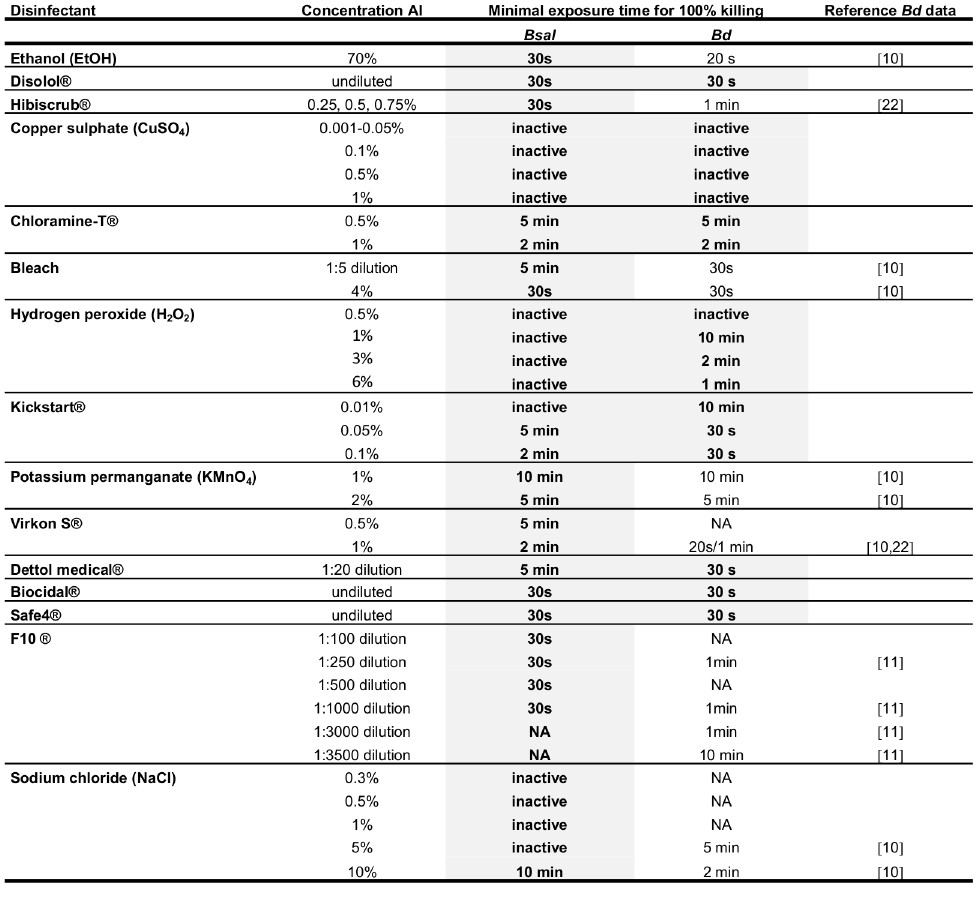
Fig 2. Efficacy of chemical disinfectants in killing Bsal and Bd . Fig 2 summarises the effect of various chemicaldisinfectantson zoospores and zoosporangia of Bsal and Bd after exposureto listed concentrations and contact times. AI: active ingredient.Conditions shaded grey were evaluated in vitro duringthis study whileother data were gatheredfrom literature.